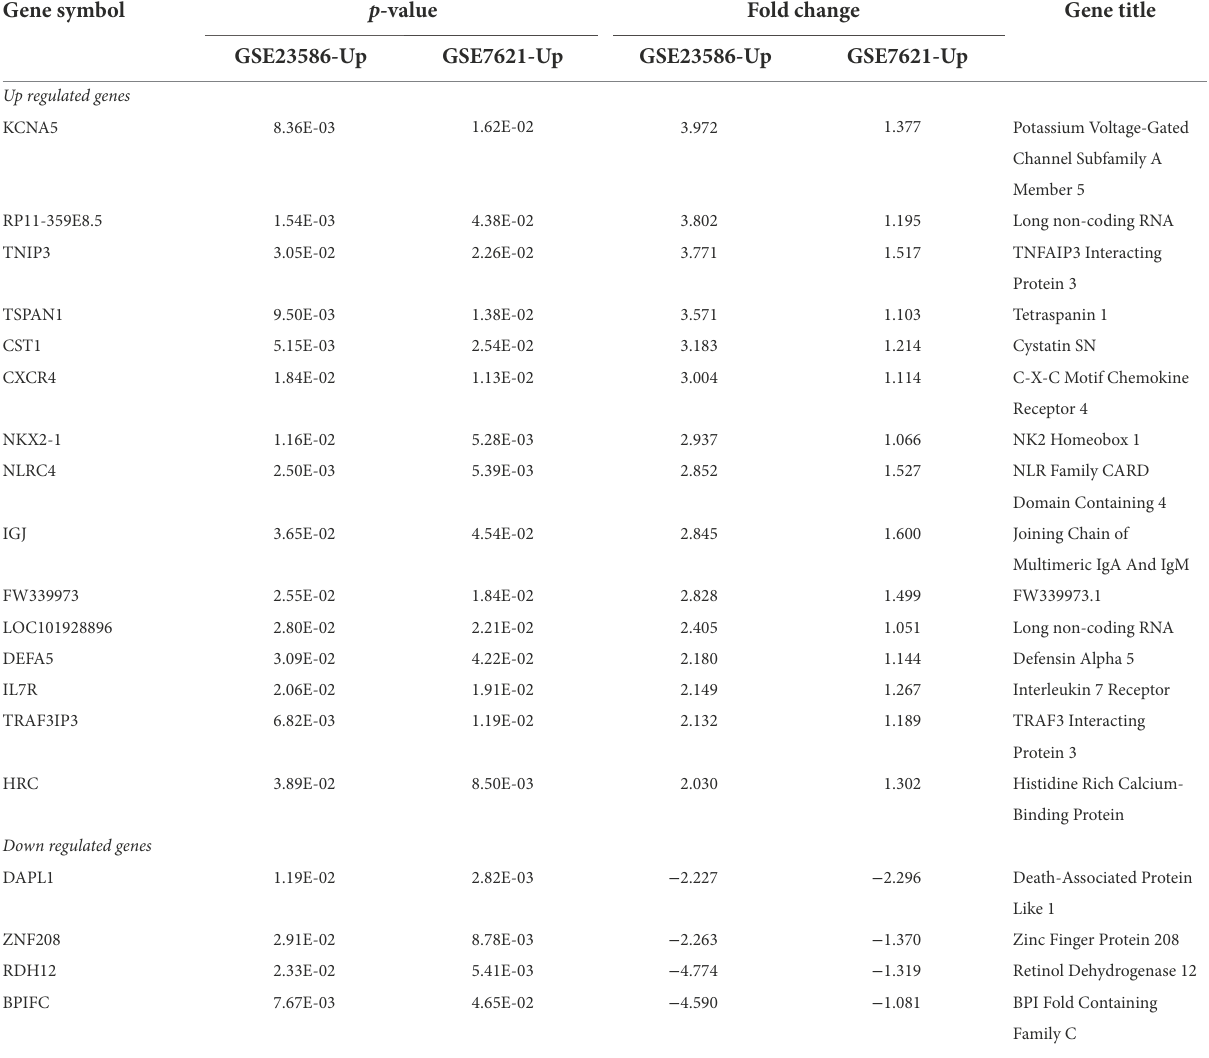
TABLE 1 Common upregulated and downregulated DEGs in GSE23586 and GSE7621. Gene symbol p